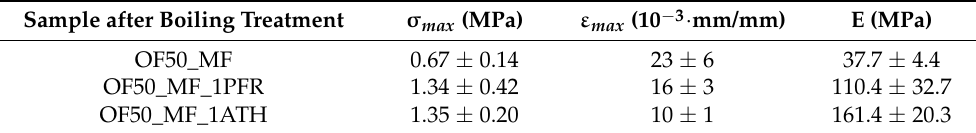
Figure 3. Stress/strain curves after the boiling treatment. Table 3. Mechanical properties of the samples after the boiling treatment. Uncertainties are reported for all data as one standard deviation calculated over six independent